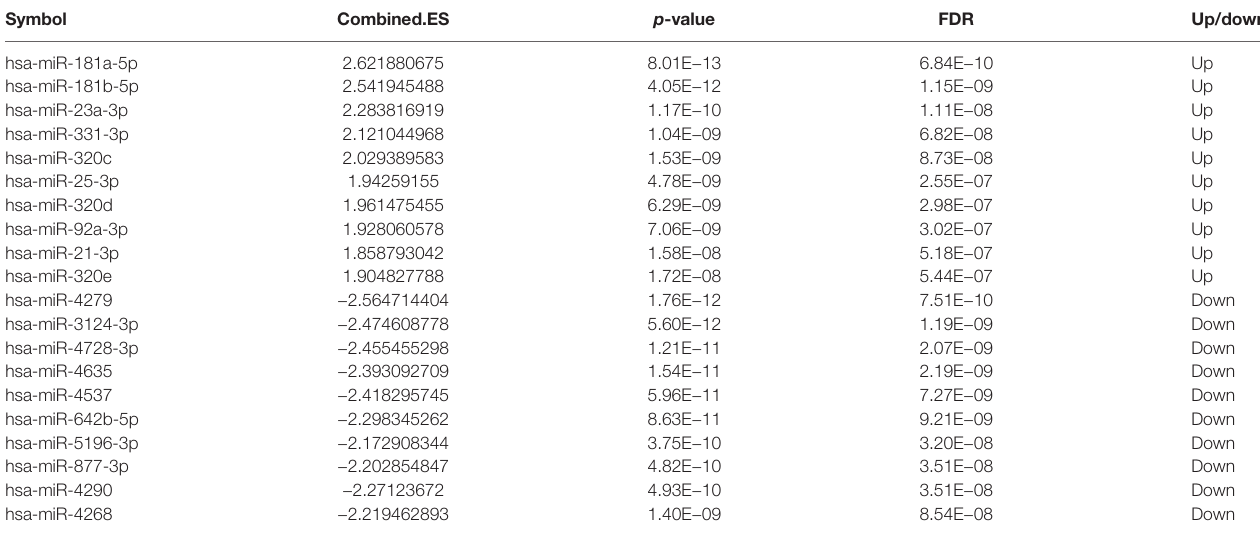
TABLE 3 | The top 10 upregulated and downregulated miRNAs in GC. Symbol Combined.ES Up/down hsa-miR-181a-5p